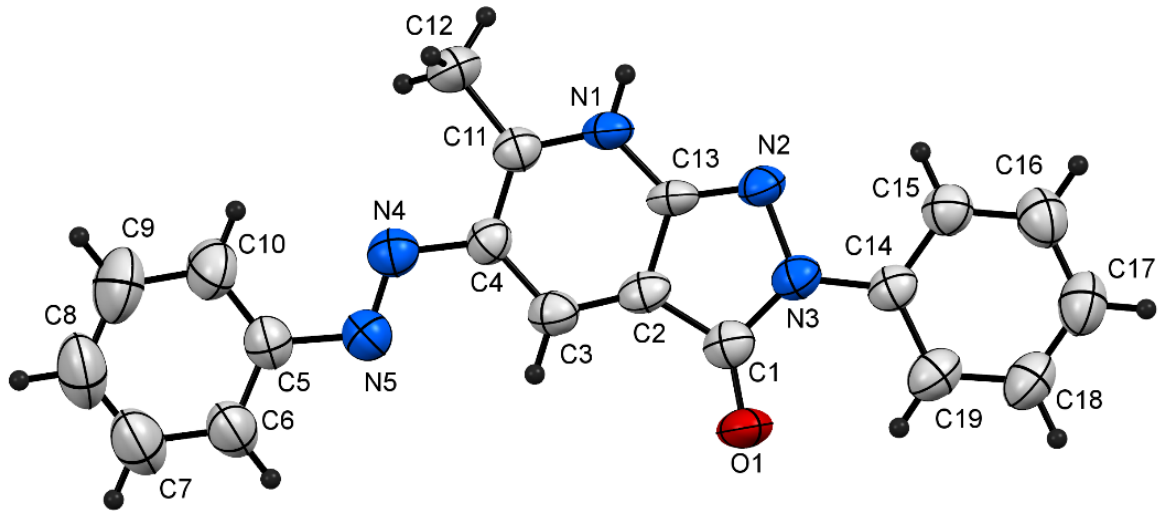
Figure 3. The X-ray crystallographic structure determined for 3v [30]. Table 2. Some selected bond lengths and angles for compound 3c .